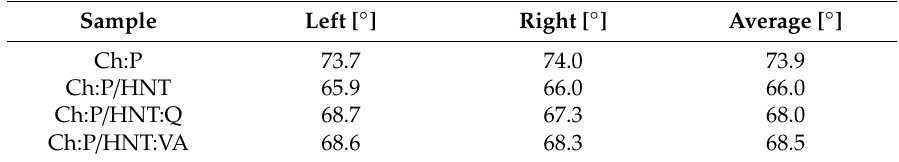
Measured contact angles of Ch:P and Ch:P containing HNT without and with natural